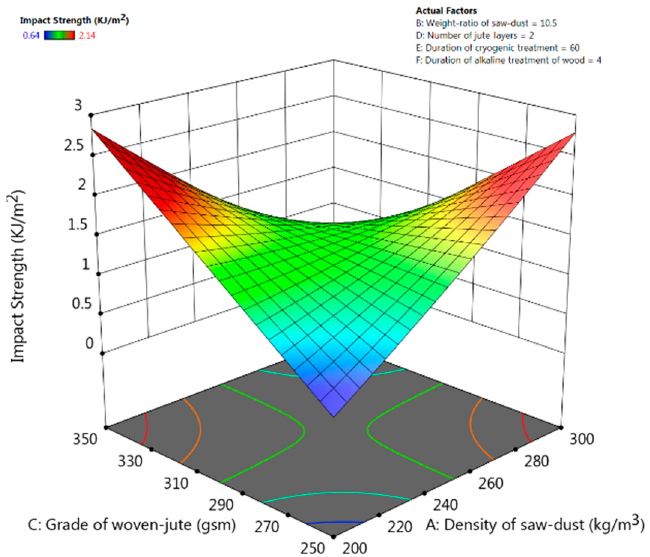
Figure 8. Response-surface plots for tensile strength for interactive effect between the density of saw-dust and the grade of